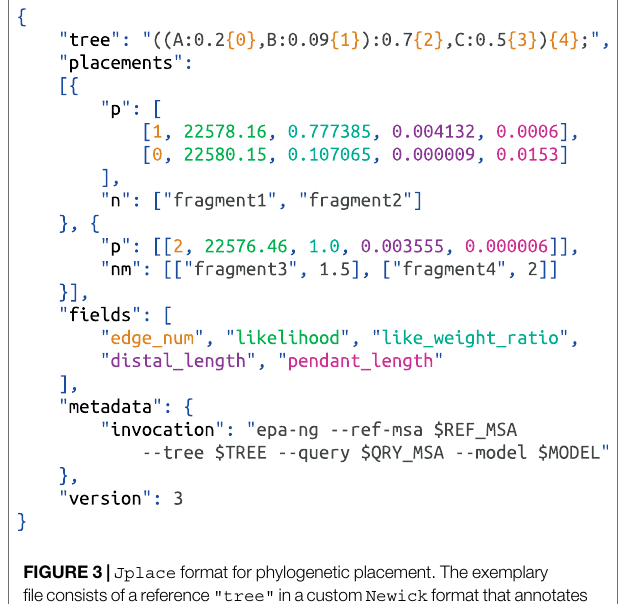
FIGURE 3 | Jplace format for phylogenetic placement. The exemplary fi leconsistsofareference "tree" inacustom Newick formatthatannotates edge numbers in curly brackets, followed by two pqueries, which is the term for combined lists of sequence names and their placement locations. The fi rst pquery contains two placement locations ( "p" ) for two query sequences ( "n" ), and the second contains a single location ( "p" ) for two other sequences including their multiplicities/abundances ( "nm" ). The order to interpret the values per location is given via the " fi elds" list, and highlighted by colors here; additional "metadata" and a "version" of the fi le format can be given. Example adapted from (Matsen et al.,